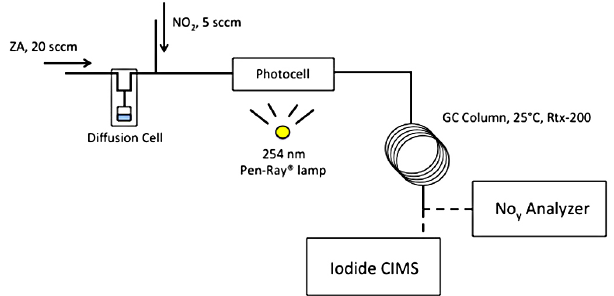
Figure 1. Shown is a schematic of the photochemical calibration system used in this work for the production of APNs with subse- quent detection using a total NO y detector and an iodide ion TD-